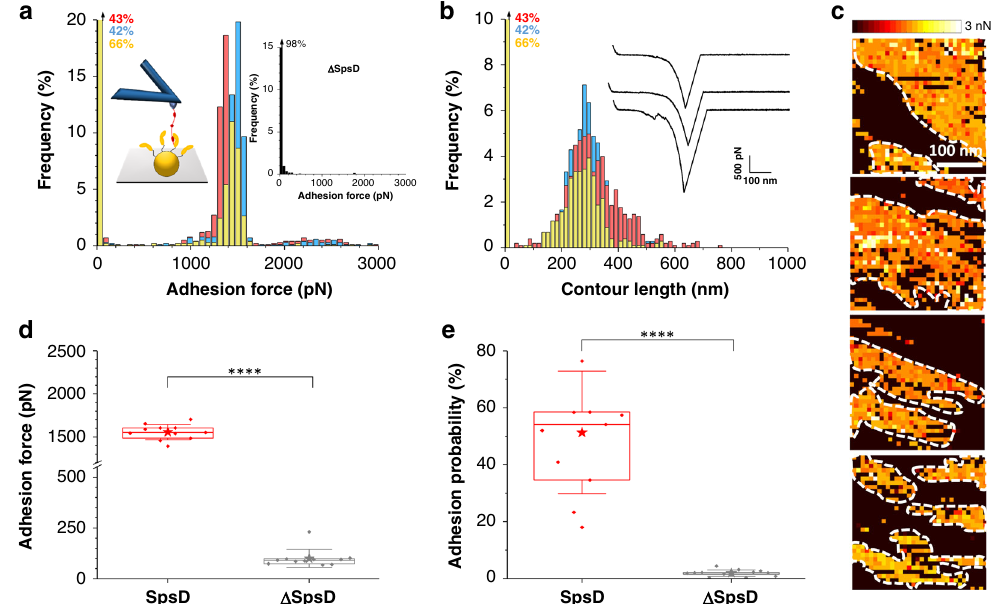
Fig. 2 Imaging and functional analysis of single SpsD adhesins on living bacteria. Maximum adhesion force ( a ) and contour length ( b ) histograms obtained by recording force – distance curves in PBS between three different S. pseudintermedius ED99 SpsD cells and AFM tips functionalized with Fg, at a retraction velocity of 1000 nm s − 1 (total number of curves from 3 cells n = 1378). Insets in ( a ) show a scheme of the setup and the adhesion force histogram obtained on Δ SpsD cells (3 cells merged). Inset in ( b ) shows representative retraction force pro fi les for SpsD cells. ( c ) Adhesion maps obtained on SpsD cells highlighting the clustering phenomenon (white dotted lines). ( d , e ) Box plots of the mean adhesion forces ( d ) and the mean adhesion probabilities ( e ) obtained for 11 cells from 5 independent cultures. Mean adhesion forces were estimated from the sharp peaks (range of 1100 – 2300 pN) shown in ( b ). Stars are the mean values, lines the medians, boxes the 25 – 75% quartiles and whiskers the SD. Student t -test: **** p ≤